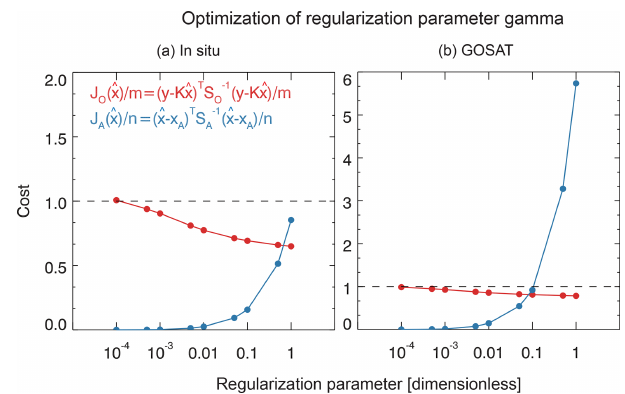
Figure 4. Optimization of the regularization parameter γ in the Bayesian cost function (Eq. 1). The figure shows the posterior ob- servation component J O ( ˆ x ) = ( y − K ˆ x ) T S − 1 terior state component J A ( ˆ x ) = ( ˆ x − x A ) T S − 1 situ-only and GOSAT-only